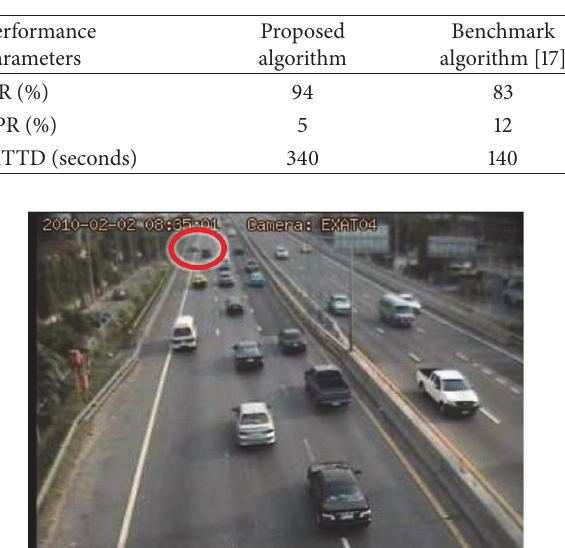
Table 2: Results on anomaly detection using data set collected in Thailand.